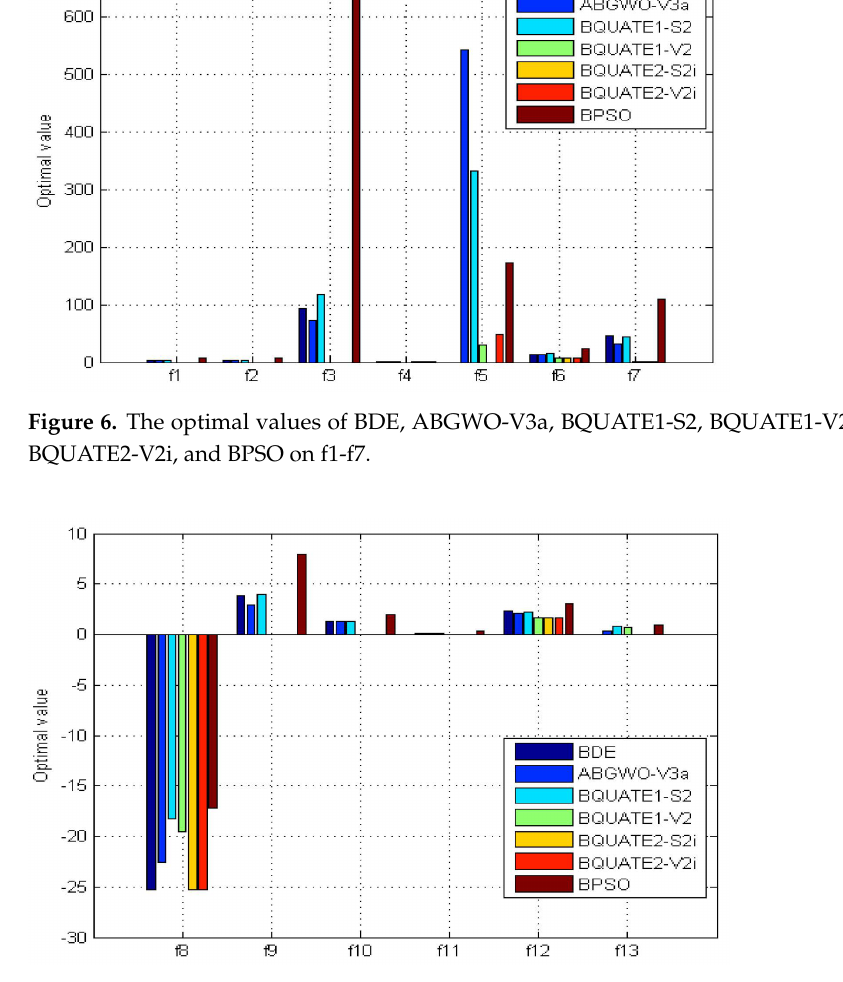
Figure 7. The optimal values of BDE, ABGWO-V3a, BQUATE1-S2, BQUATE1-V2, BQUATE2-S2i, BQUATE2-V2i, and BPSO on f8-f13.